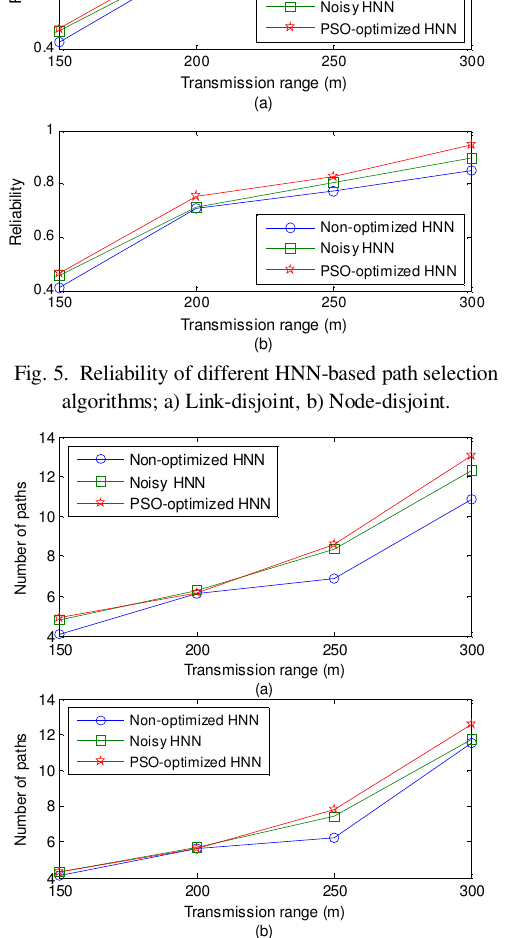
Fig. 8. Reliability for different number of nodes using HNN- based algorithms; a) Link-disjoint paths, b) Node-disjoint